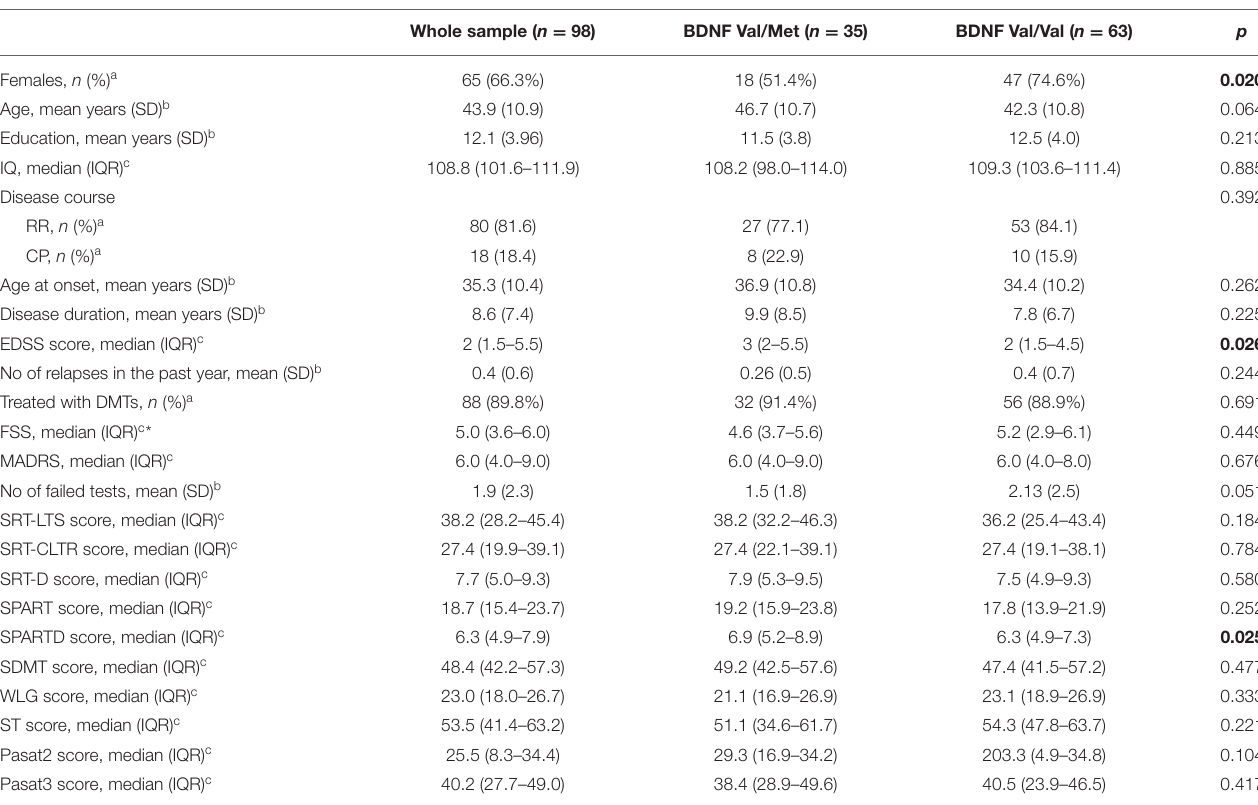
TABLE 1 | Characteristics of the study sample.